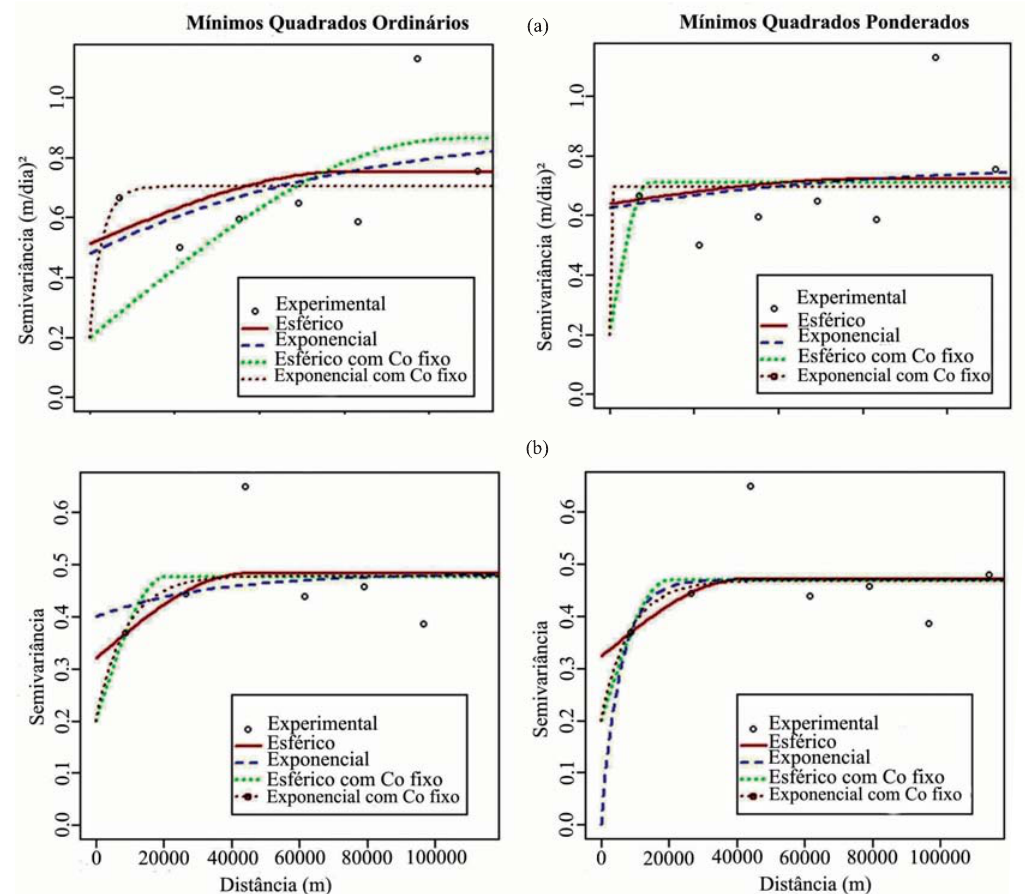
Figura 8. Semivariogramas experimentais e teóricos dos dados de condutividade hidráulica saturada sem (a) e com transformação